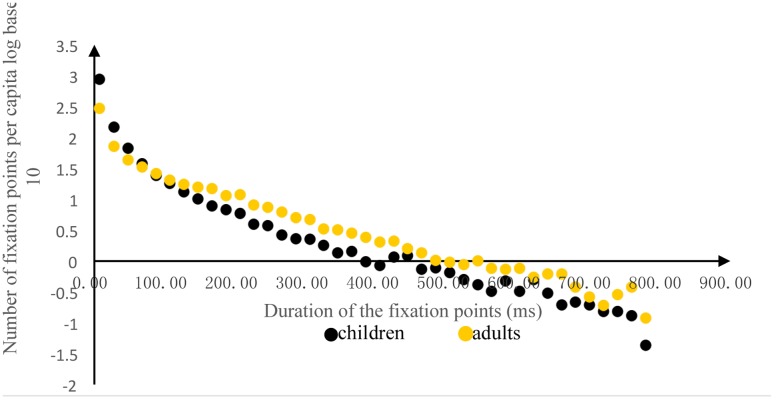
Logarithmic distribution (log base 10) of the per-capita duration of different fixation points.